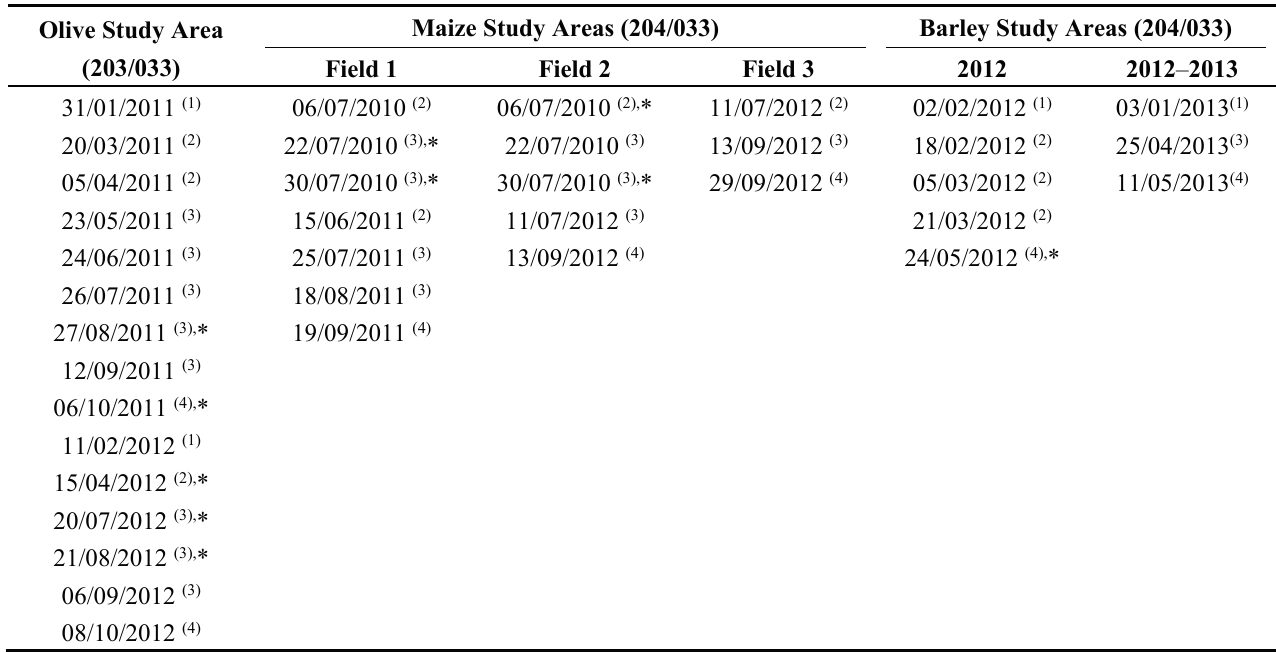
Table 2. Satellite image dates considered for each study area and